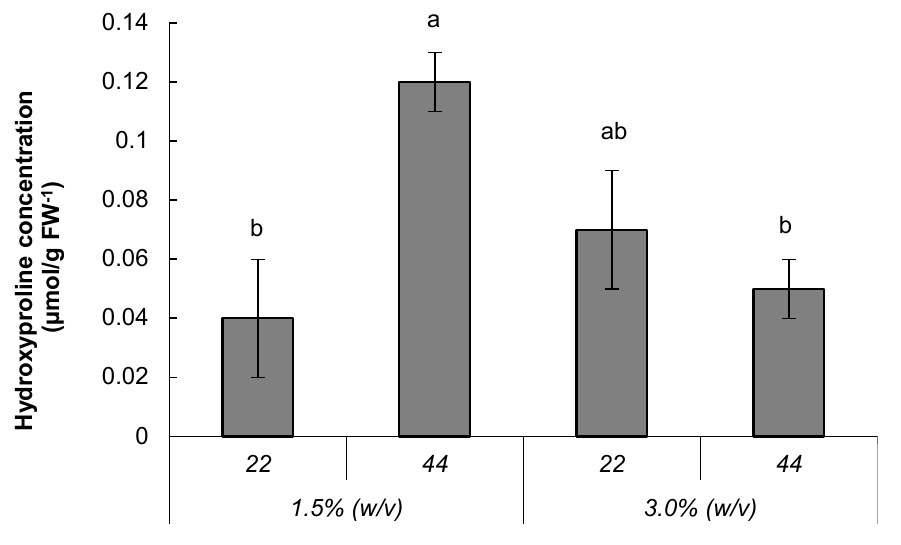
Figure 7. Effect of 6-Benzyladenine (BA) (22 and 44 µ M) and sucrose concentration (1.5 and 3.0% ( w / v )) on hydroxyproline amino acid level of Pinus radiata D. Don shoots cultured in Quoirin and Lepoivre (LP) medium [27], modified according to Aitken-Christie et al. [28], supplemented with 2 gL − 1 activated charcoal. Data are presented as mean values ± S.E. Different letters indicate significant differences by Duncan’s post hoc test ( p < 0.05).